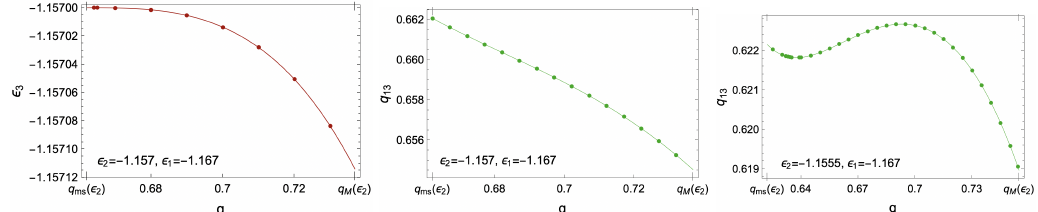
of the minima reached asymptotically by the dynamics 3 of the saddle. Middle and Right. The behavior 2 with q depends on ε : for ε sufficiently small, q 13 2 2 13 closer to the threshold, the behavior 2